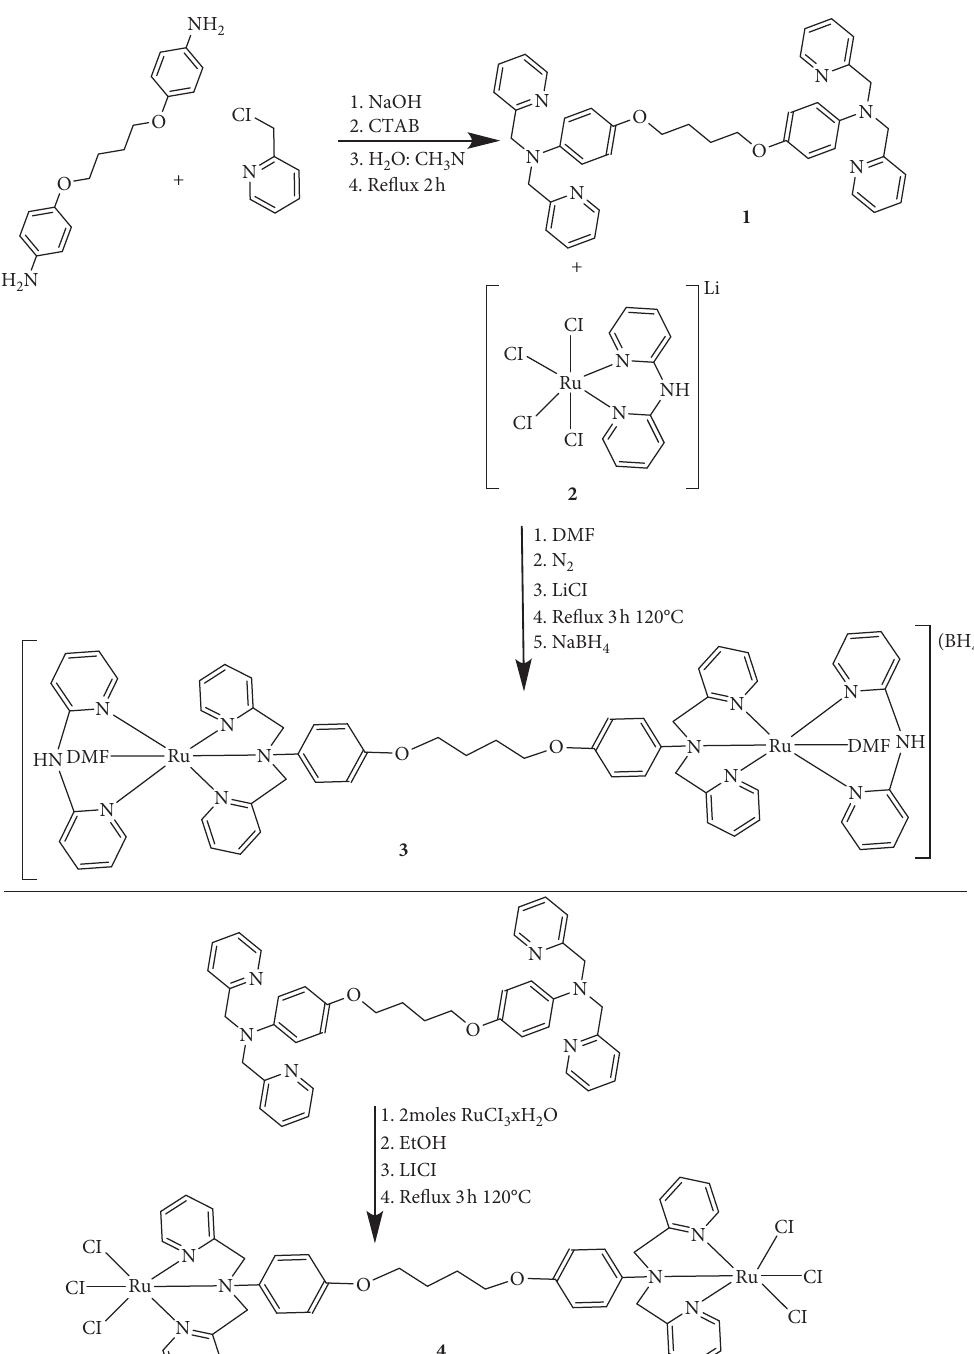
2 (2BUT)(DMF) 2 (DPA)](BH 4 ) 4 (3) and [Ru 2 (2BUT)(Cl) 6 ]